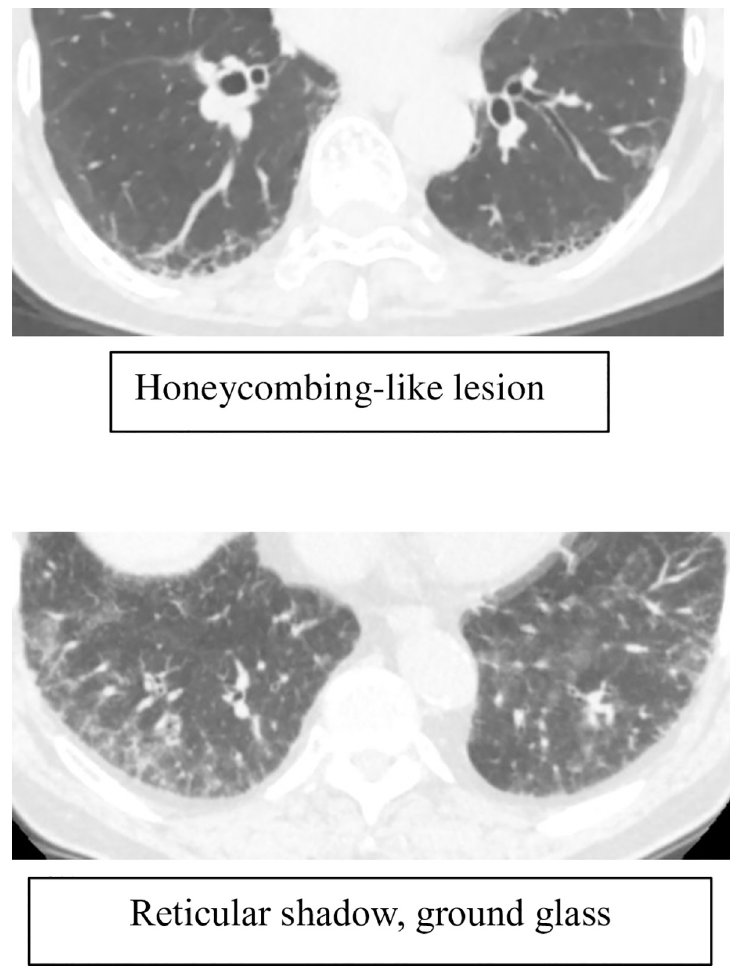
Fig 1. Representative pictures of the patterns of ILAs (honeycombing-like lesion, reticular abnormalities, and ground-glass opacities).